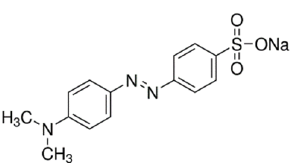
2.3. Cationisation of Coon Fabric Cationisation of coon fabric was carried out in a laboratory dyeing machine using the exhaust method. The coon fabric was immersed in an aqueous solution of Denimcol FIX-OS, concentration of 6% o.m.f. at goods-to-liquor ratio (LR) of 1:10. After 5 min, 3 mL/L NaOH 38° Bé was added, and the fabric was treated at 50 °C for 15 min. After cation- isation, the coon fabric was rinsed twice with deionised water. Then neutralisation was carried out with 5 mL/l CH 3 COOH 30% at room temperature for 10 min. After neutralisa- tion, the fabric was again rinsed twice with deionised water at room temperature. 2.4. Dyeing Prior to dyeing, preliminary experiments were conducted to determine appropriate LR and the concentration of the electrolyte (NaCl), while the concentration of the MO dye was taken from literature in which the dyeing of coon fabrics was carried out using the MO dye [8]. Thus, exhaust dyeing was carried out at LR of 1:20 and 1:40 at five different NaCl concentrations, namely 3, 10, 20, 30 and 40% o.m.f. The preliminary tests showed that the highest adsorption of the dye was obtained at lower LR and higher NaCl concen- tration. Therefore, the research was continued with LR of 1:20, a NaCl concentration of 30% o.m.f., and a MO concentration of 0.3% o.m.f. Dyeing of the 10 g coon fabric was carried out in the Starlet 2 laboratory dyeing machine (Daelim, Korea) according to the diagram shown in Figure 2. Dyeing lasted 60 min at optimum dyeing temperature (100 °C). After dyeing, two rinses were performed, the first at 40 °C and the second at room temperature with deionised water. The dyed fabric was dried in the air at room tempera- ture (23 °C). Figure 2. Dyeing diagram (F—fabric, D—dye solution, E—electrolyte solution).